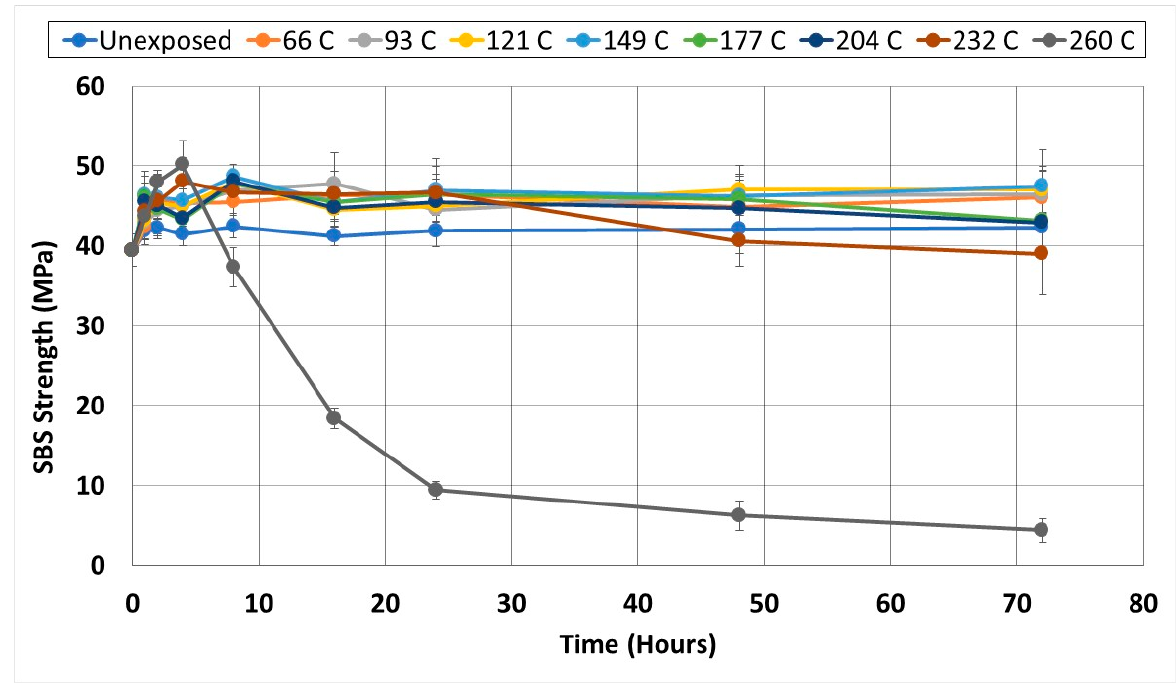
Figure 8. Change in short beam shear strength as a function of exposure temperature and time.